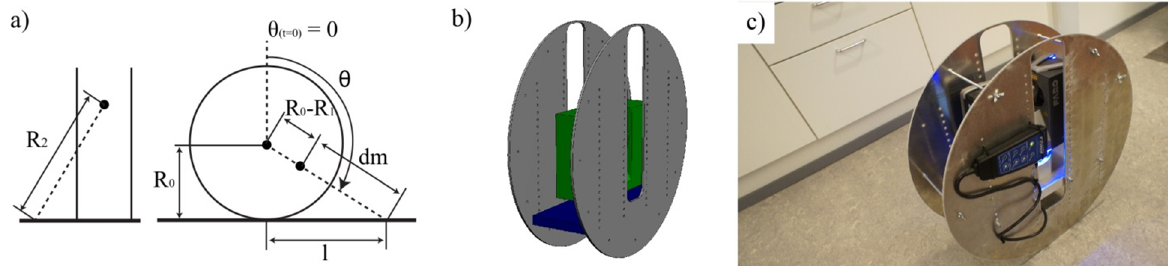
Figure 1. (a) A schematic describing the path parameter θ (t) and constants R b) VILMA assembly schematics. c) A 2D laser scanner, here Faro Focus 3D in helical mode, is attached in between two metallic discs so that it retains a wide viewing angle through the oval holes carved on the discs. This figure is reproduced from (Lehtola et al.,